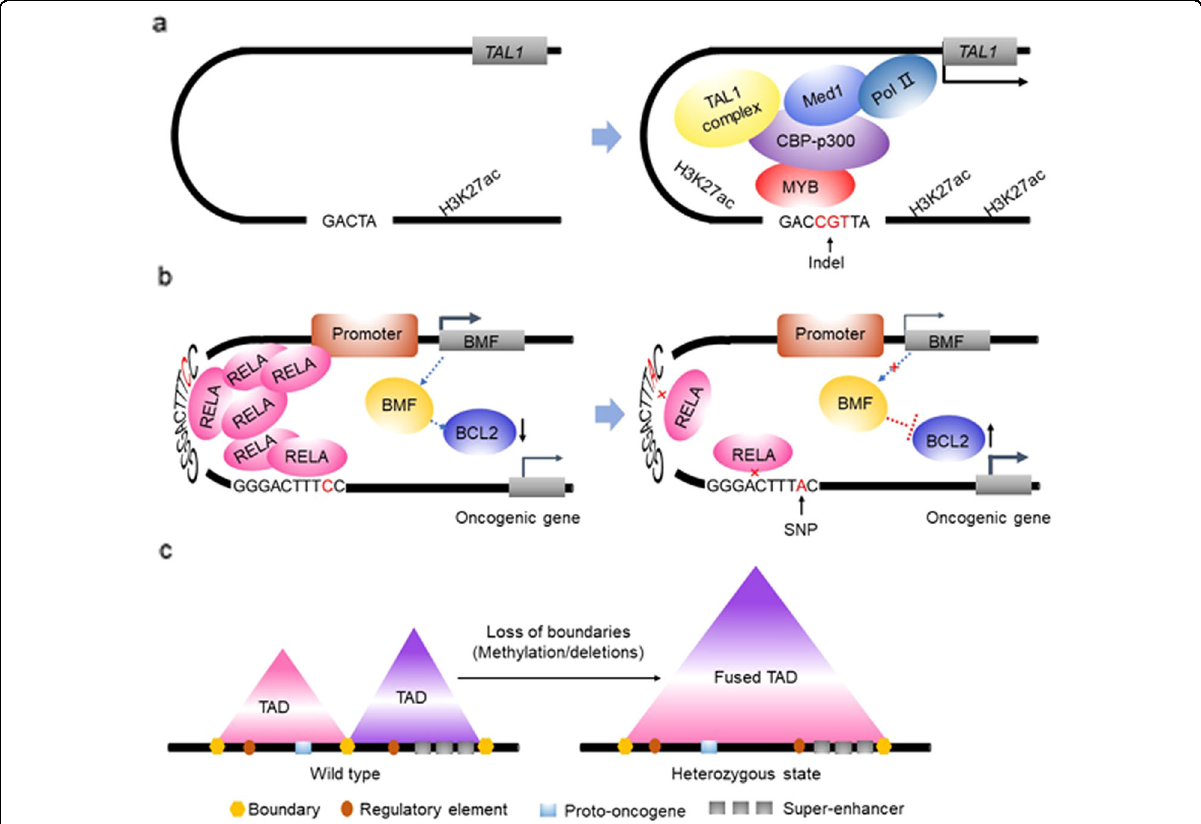
Fig. 2 Various mechanisms of oncogenic SE formation. a Small insertions in the noncoding intergenic region upstream of the TAL1 oncogene induce de novo binding sites for the TF MYB, leading to the formation of SEs that drive TAL1 expression. MYB binds and recruits its H3K27 acetylase binding partner CBP, the TAL1 transcriptional complex containing RUNX1 and GATA-3. b The SNPs in the 15q15.1 risk locus generate SEs for the proapoptotic gene BMF and disrupt the binding of the TF RELA to SEs, leading to activation of the antiapoptotic function of BCL2 and promoting tumorigenesis. c Oncogene activation occurs via structural variations or epigenetic